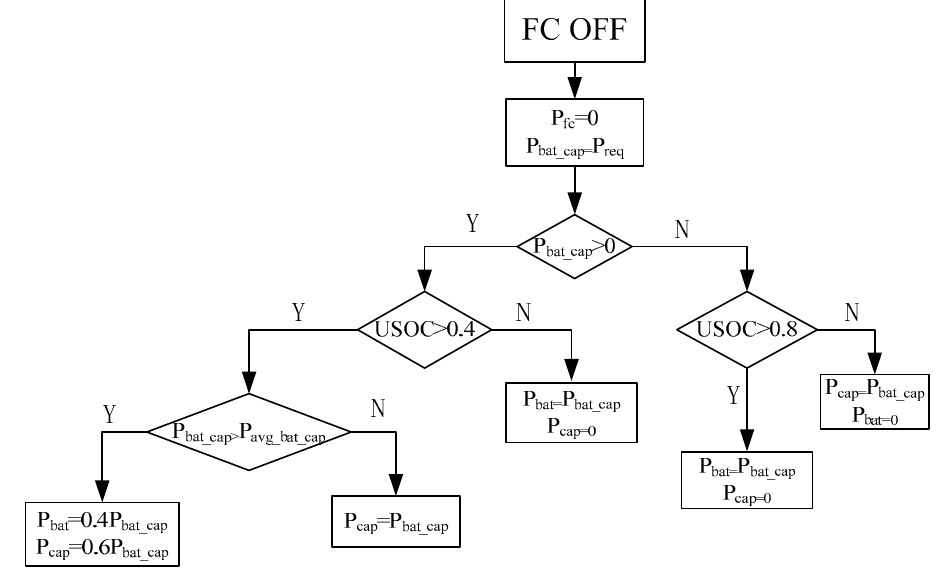
Figure 8. Flowchart of rules for energy management when the fuel cell is off.